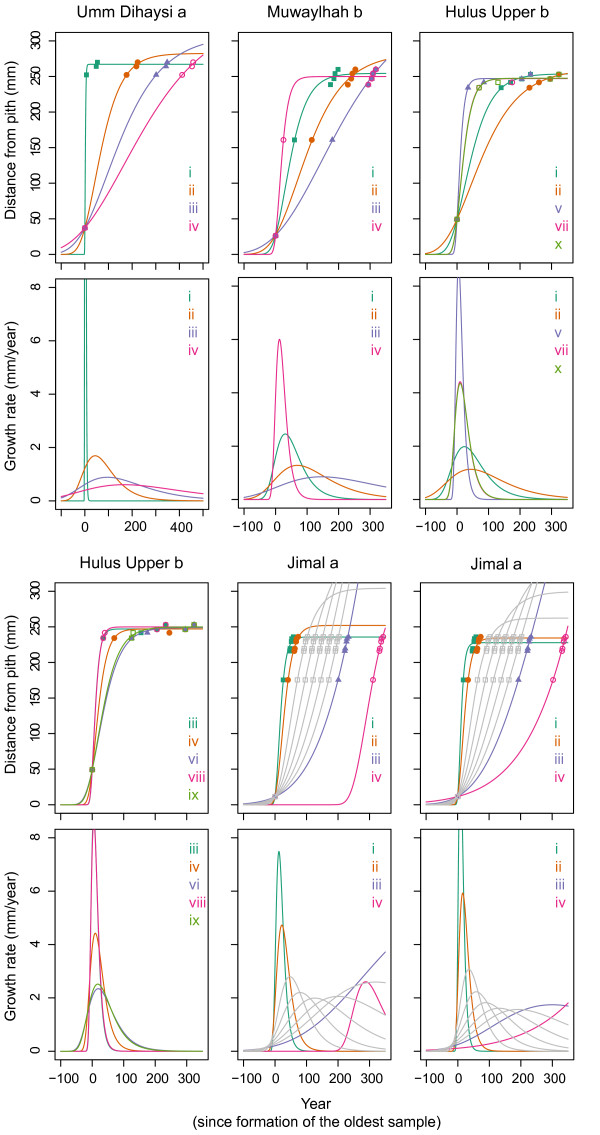
Plots of age scenarios. The upper panel shows cumulative growth, and the lower panel differential growth as modelled by the Gompertz equation. The oldest sample is by definition formed in year 0. Establishment is defined as the year in which cumulative radial growth is at least 1 mm, and will be negative compared to the oldest sample from the core in question. Scenario names refer to Table 2. Grey lines (for Jimal a) show scenarios based on 25-year interval dates within 2 sigma ranges for sample VI, i.e. 1800, 1825, 1850, 1875 and 1900. Note the different x-scale on Umm Dihaysi a.